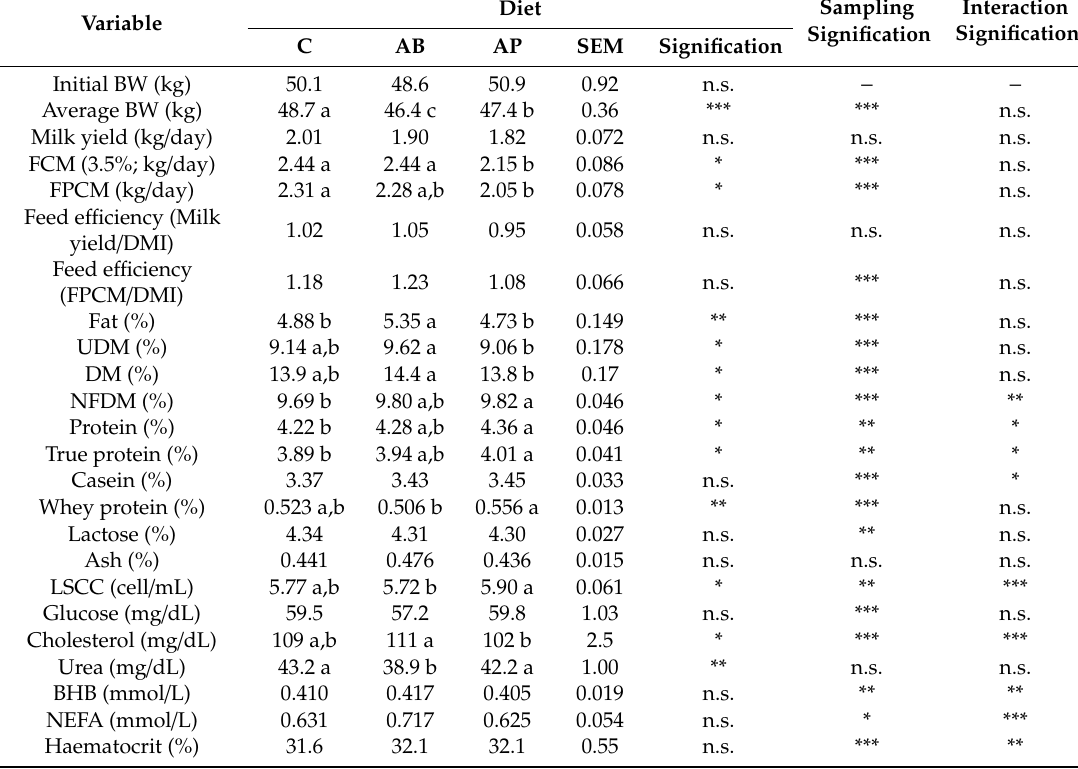
Table 3. Results of the comparison of means of the variables related to body weight, food intake, milk yield and composition, somatic cell count and basal metabolism, according to the e ff ects considered, in Experiment